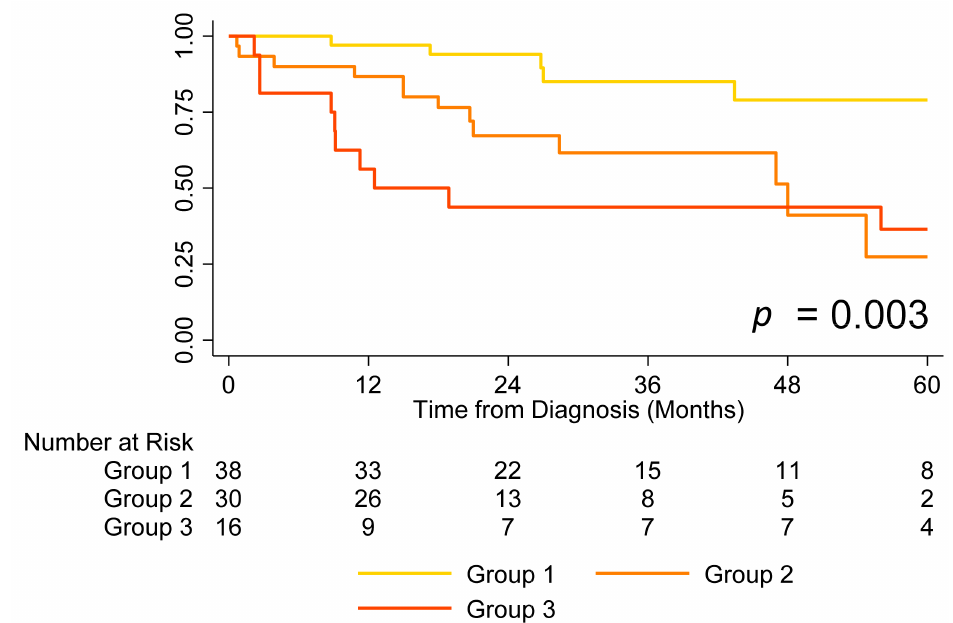
Figure 4. Transplant-free survival by risk group using both tricuspid annular plane systolic excursion (TAPSE) and degree of tricuspid regurgitation (TR) to further stratify intermediate-risk patients (Group 1: TAPSE ≥ 19 mm and no/trace/mild TR; Group 2: TAPSE < 19 mm or moderate/severe TR; Group 3: TAPSE < 19 mm and moderate/severe TR). Note: Graphs for low- and high-risk patients are not shown to avoid crowding the figure; five intermediate-risk patients had missing TAPSE or degree of TR and were not included in the